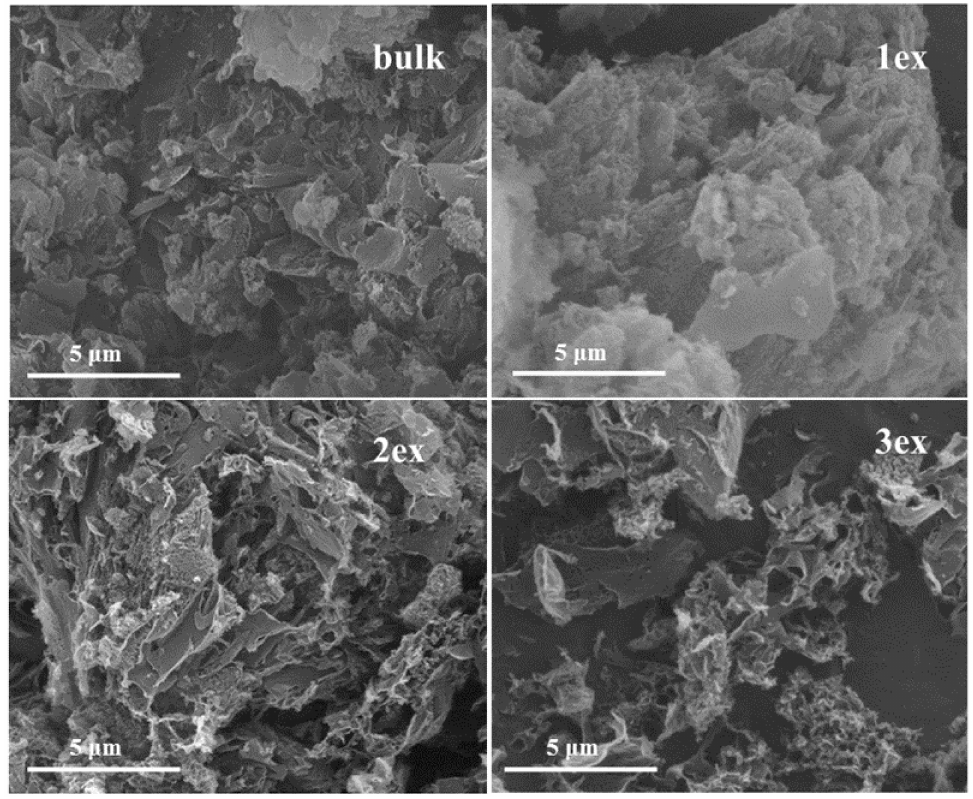
Figure 2. Images of the synthesized (bulk) and exfoliated (1ex, 2ex and 3ex) g-C 3 N 4